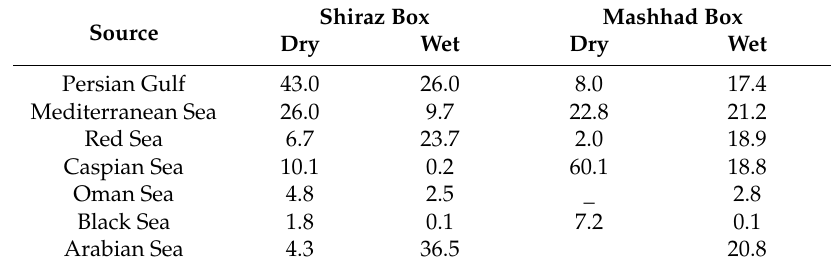
Table 2. The percentage of moisture uptake from diverse marine origins during the wet and dry periods for the Shiraz and Mashhad boxes from 1981 to 2015 Diverse Moisture Sources Contribution (%) in the Total Moisture Uptake